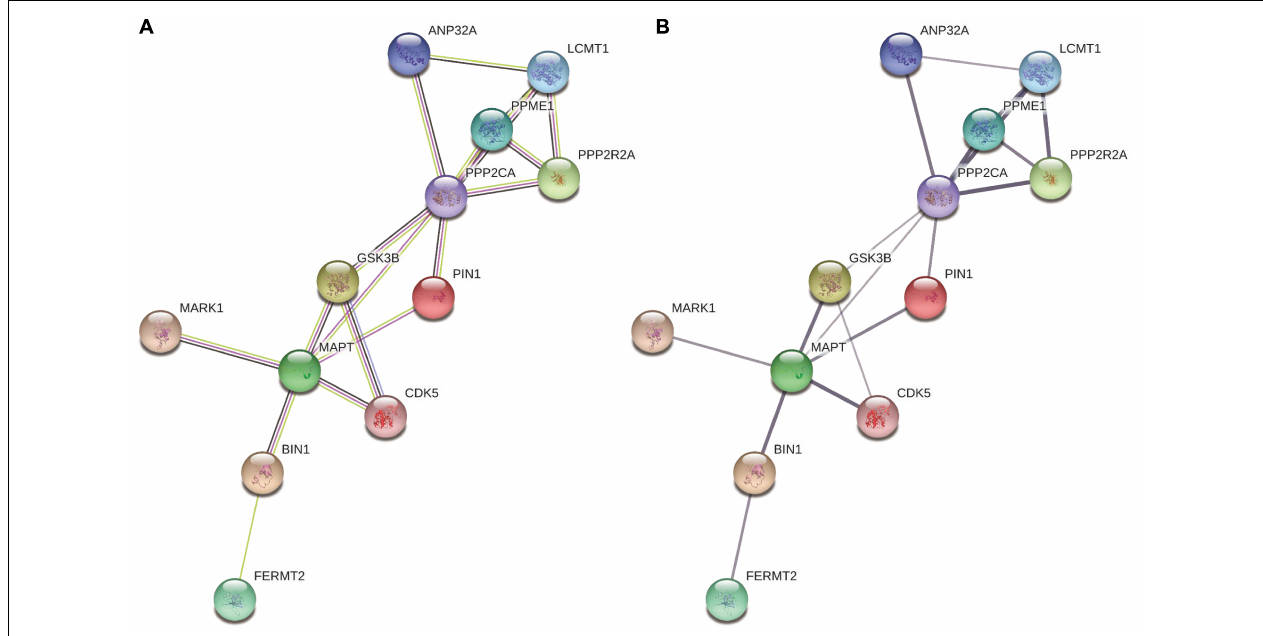
FIGURE 4 | The interaction between BIN1 and other proteins involving the metabolic pathways of tau. (A) Colors represent different evidence sources (the experimental results, pink line; text mining sources, yellow line; gene co-expression, black line). (B) The thickness indicates the strength of protein interaction.